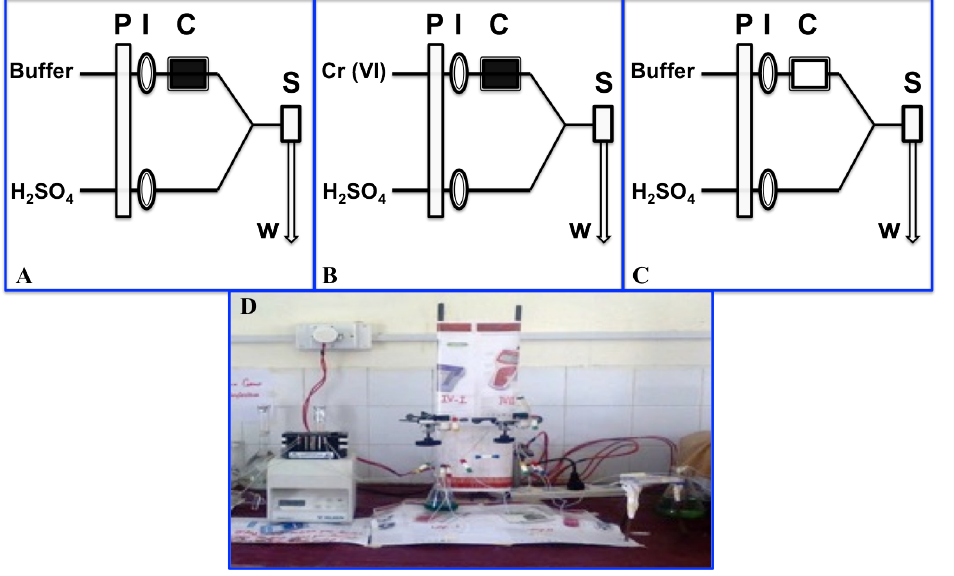
Figure 1: Flow injection manifolds and procedure (A) preconcentration, (B) washing and (C) elution and (D) image of the flow system used in this study (where P, I, C, S and w represents pump, injector, column, spectrophotometer and waste).